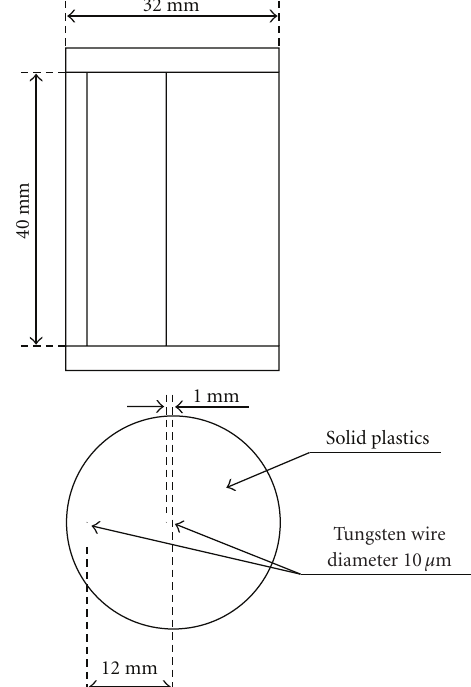
Figure 4: Dimensions of the micro-CT wire phantom.